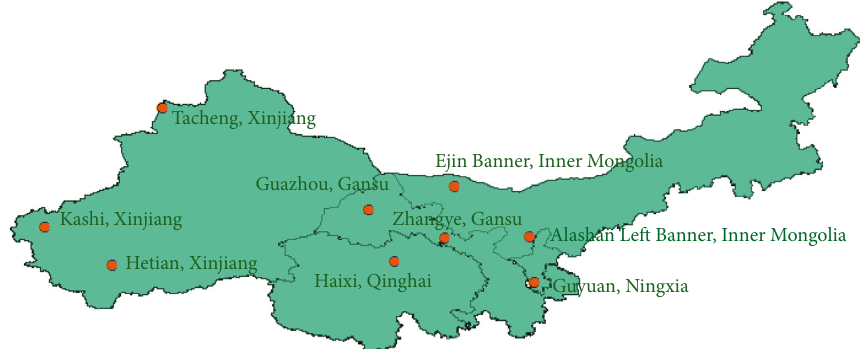
Figure 1: The sampling points of C. songaricum